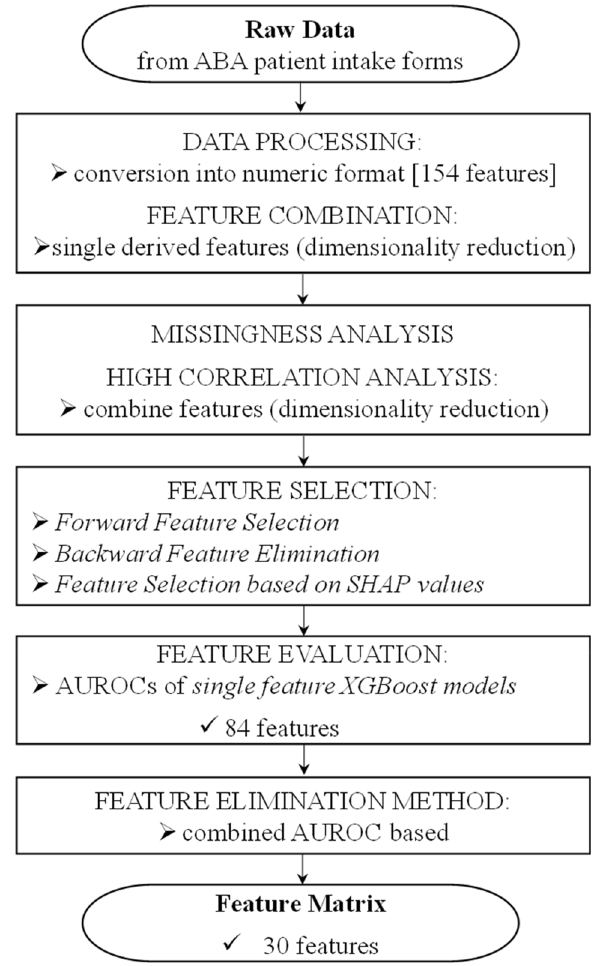
Fig. 1 Data processing and feature selection flowchart. The raw data from the ABA intake forms were processed and subjected to rigorous feature selection to generate the feature matrix used to train and test the machine learning (ML) prediction model. ABA applied behavioral analysis; SHAP SHapley Additive exPlanations; AUROC area under the receiver-operator characteristic